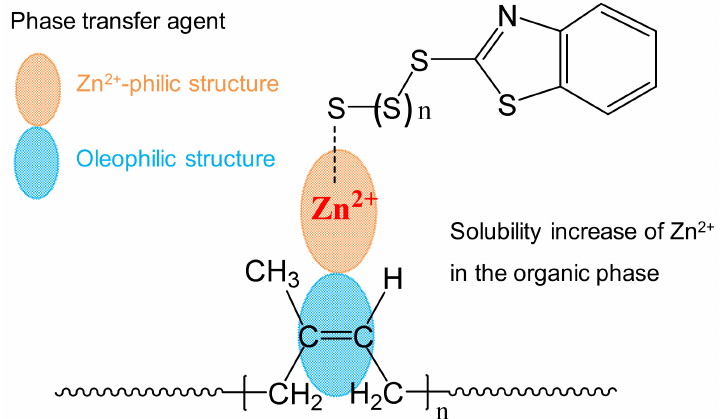
Figure 1. Conceptual scheme of phase transfer agent tuning the solubility of Zn 2+ in the organic